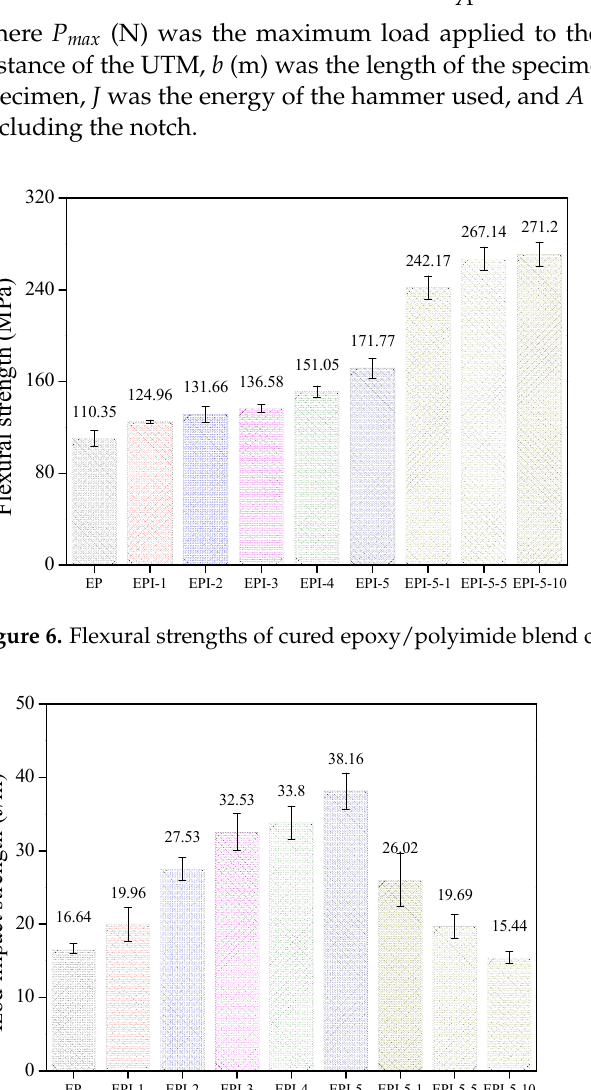
Figure 7. Izod impact strengths of cured epoxy/polyimide blend composites.